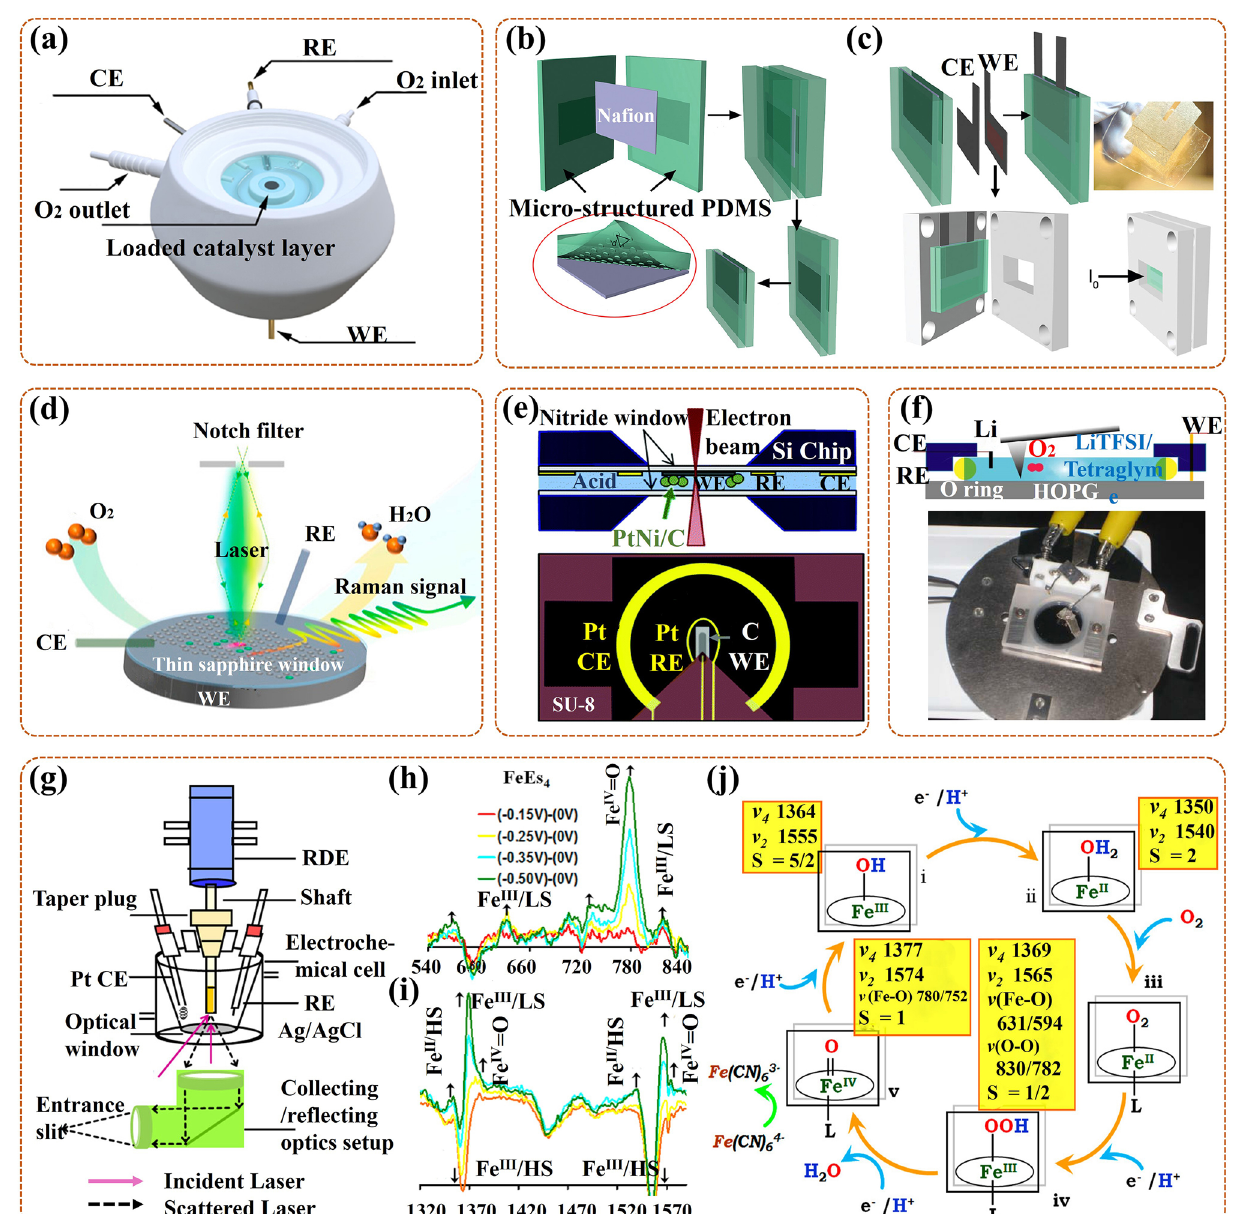
Fig. 16 a Schematic of in-situ open XRD cell; [154] Reused with approval; Copyright 2020 Elsevier. b Fabrication schematic of the PDMS pouch, with enlarged part of the morphology for micro-structured PDMS; c Assembly schematic of in-situ XAS cell, with optical photo of the PDMS pouch [155]; Reused with approval; Copyright 2012 American Chemical Society. d Schematic of in-situ modified Raman cell [141]. Reused with approval; Copyright 2022 American Chemical Society. e Schematic of in-situ TEM liquid electrochemical chip, with a cross-sec- tional view of the holder for the cell on the top and the three electrodes view on the bottom [156]; Reused with approval; Copyright 2019 Royal Society of Chemistry. f Schematic of in-situ AFM cell on the top, with its optical photo on the bottom [157]; Reused with approval; Copyright 2012 American Chemical Society. g Schematic of in-situ SERRS with the RDE electrochemical cell; In-situ difference spectra of the SERRS- RDE data for Iron Porphyrin (FeEs 4 ) h in the low-frequency extent, and i in the high-frequency extent; j Schematic of probable ORR mechanism [139]. Reused with approval; Copyright 2016 American Chemical